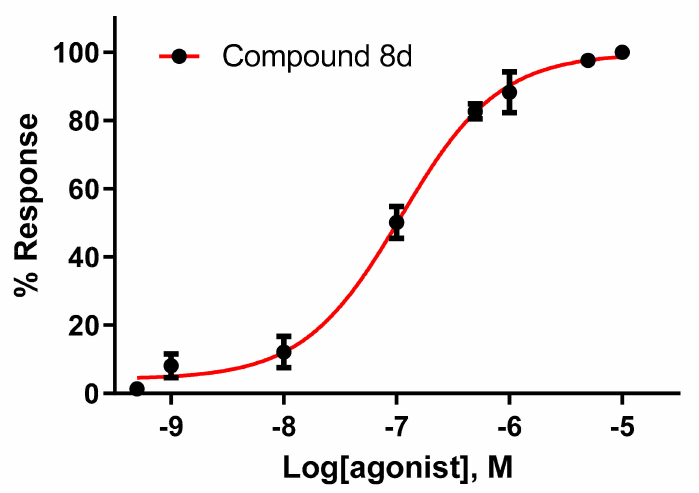
Figure 2. Concentration-response curve of compound 8d in the CB2R. The result showed an EC50 = 0.11 µ M. Each point represents mean values with standard error ( n =